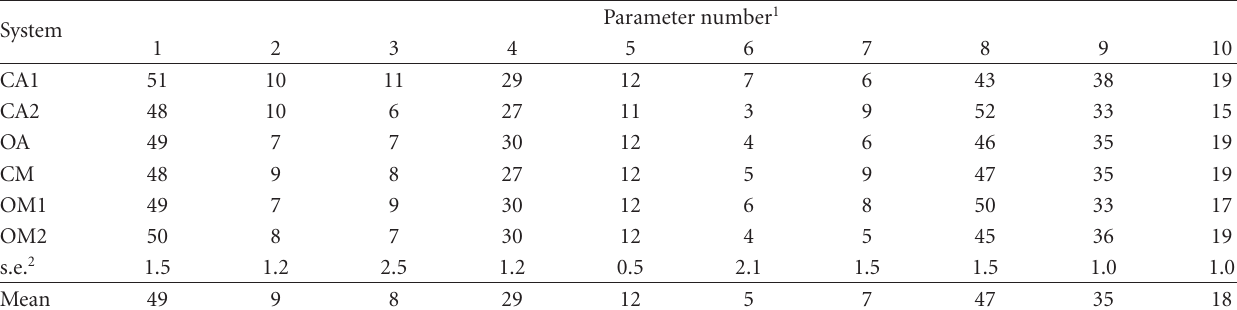
Table 1: Mean values of selected soil physical parameters in topsoil (0–30cm) measured in 1988, prior to the start of the experiment (from